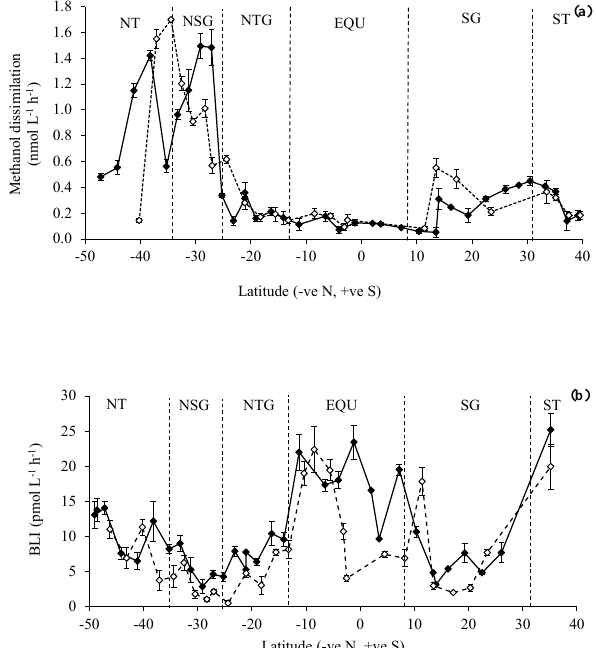
Figure 2. Variability in (a) microbial methanol dissimilation rates (using the specific activity of 14 CH 3 OH) and (b) bacterial leucine incorporation (BLI), in surface waters of the Atlantic Ocean. Rates were determined from pre-dawn ( (cid:7) , solid line) and solar noon ( dashed line) CTD casts. Error bars represent ± 1SD of triplicate samples and dashed vertical lines indicate Atlantic province bound-